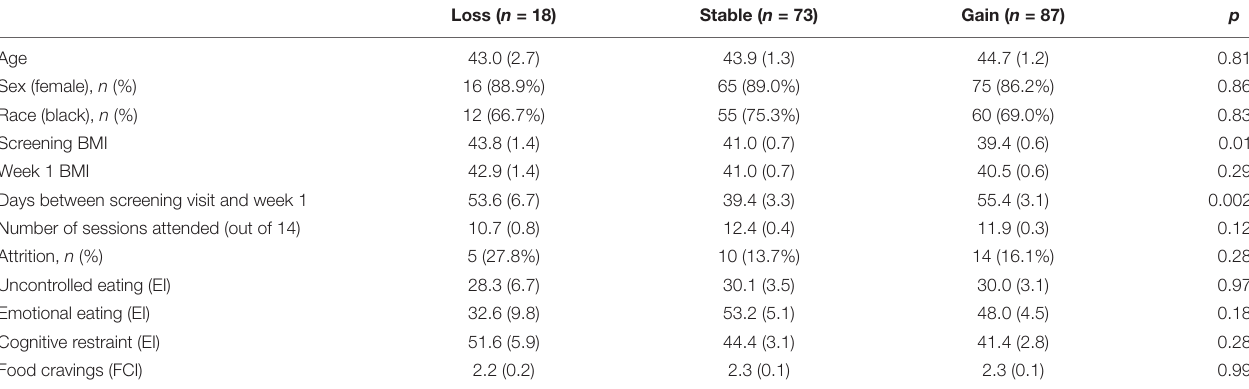
TABLE 1 | Differences among pre-treatment weight change categories in demographic characteristics and baseline psychosocial